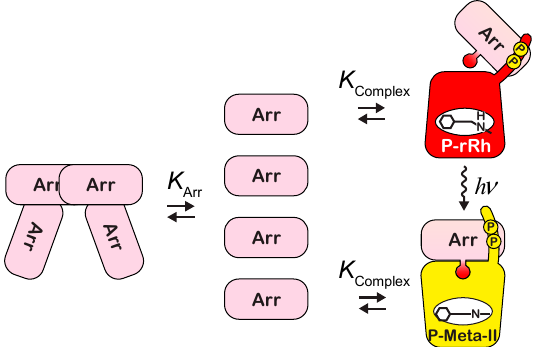
Figure 5. Interaction between phosphorylated rhodopsin and arrestin tested in the current experi- ments.